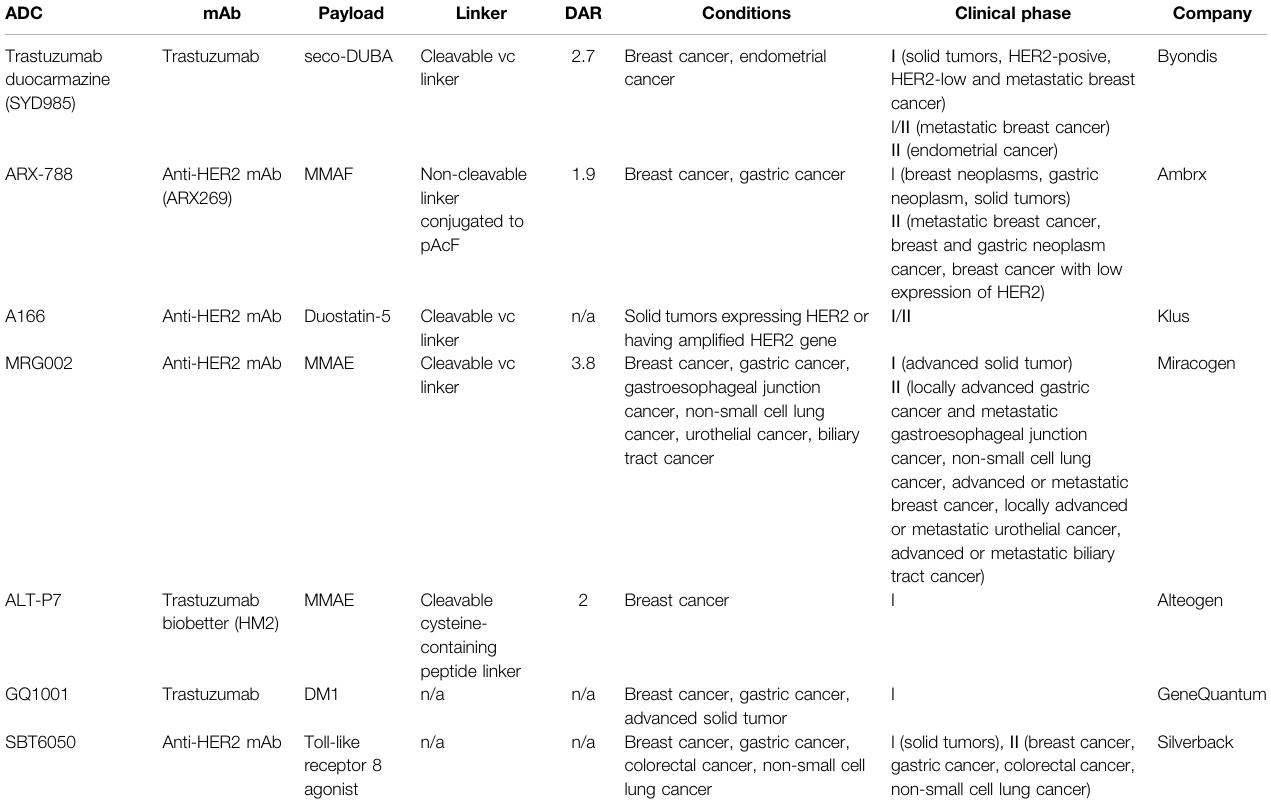
TABLE 3 | Summary of anti-HER2 ADCs in clinical investigation.